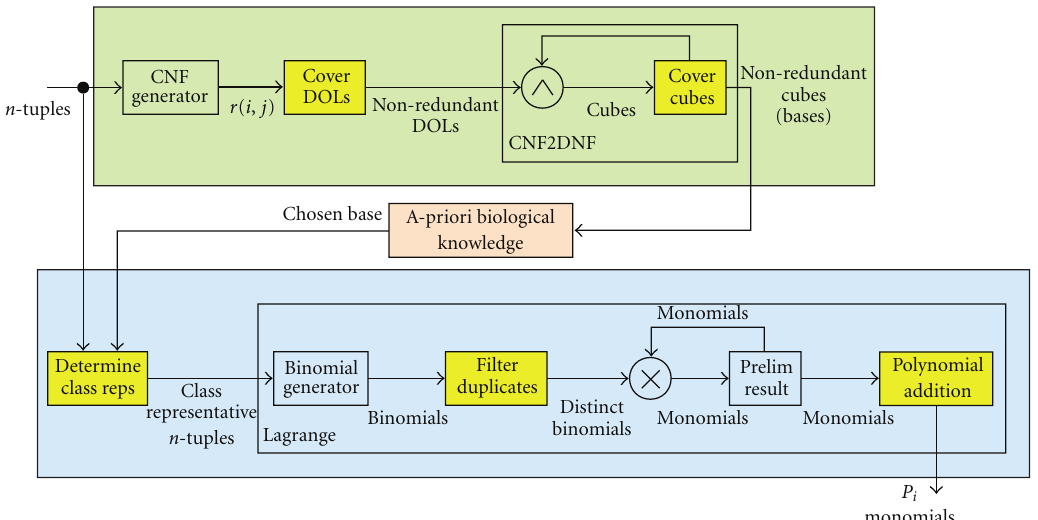
Figure 1: Block diagram of the implementation, highlighting the subtasks that are implemented using the systolic array architecture.